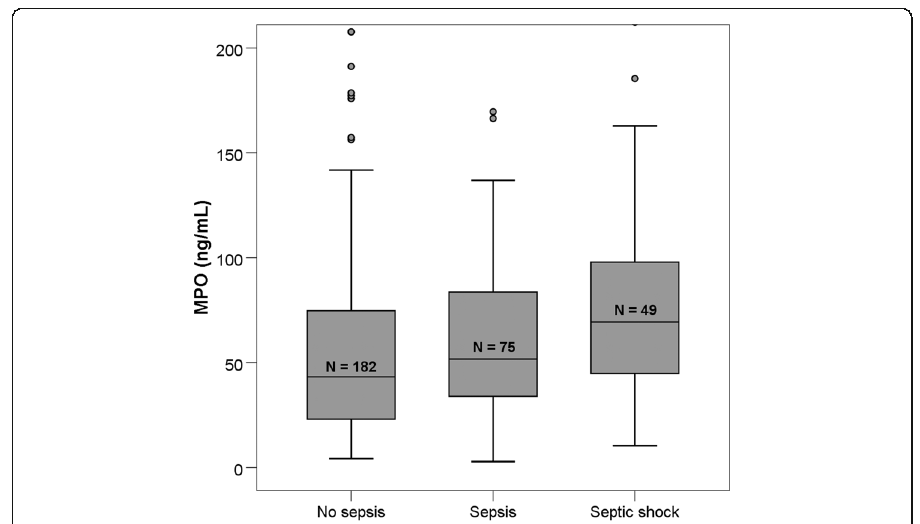
Fig. 1 Myeloperoxidase (MPO) levels in different states of inflammation. Septic shock has higher MPO levels compared with sepsis, P = 0.04. Patients with sepsis (sepsis + septic shock) have higher MPO levels compared with patients without sepsis, P = 0.002